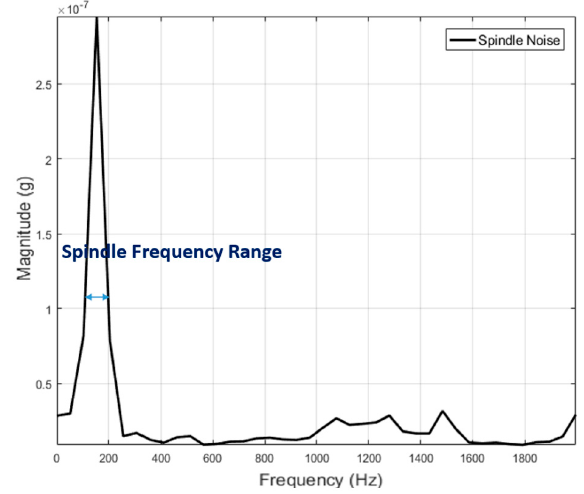
Figure 4. Vibration signal from spindle.